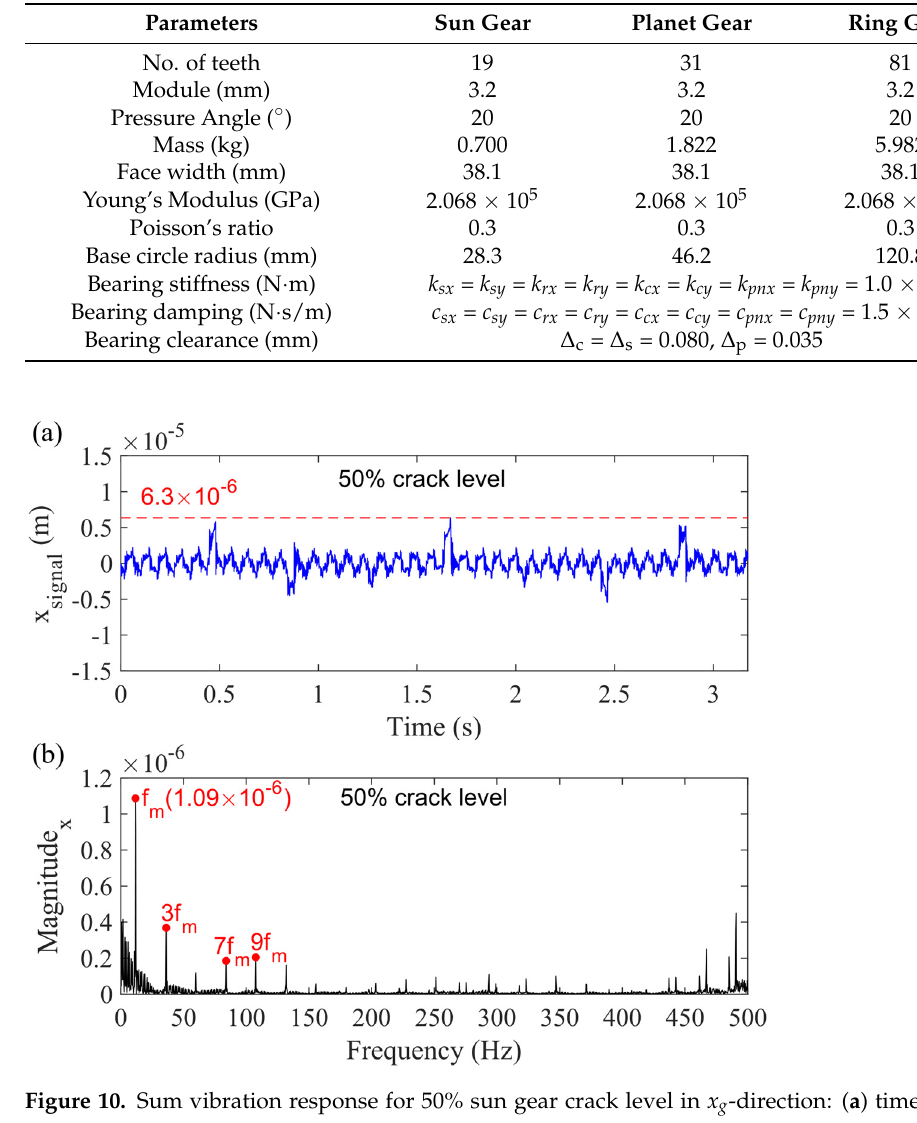
Figure 11. Vibration response of carrier for the 50% sun gear crack level for ( a ) Case 1 and ( b ) Case 2, both in x g -direction. Other vibration responses for sun gear, planet gears, and ring gear can also be generated by the motion equations. Then, the sum vibration signal for the planetary gearbox can be obtained by adding these signals together through the Equations (10)–(12). Figure 12a presents the sum vibration signal for the case considering the carrier bearing clearance for the 50% sun gear tooth crack level, while (b) is the spectrum. Comparing Figure 12 to Figure 10, it is found that the highest value of the signal is significantly